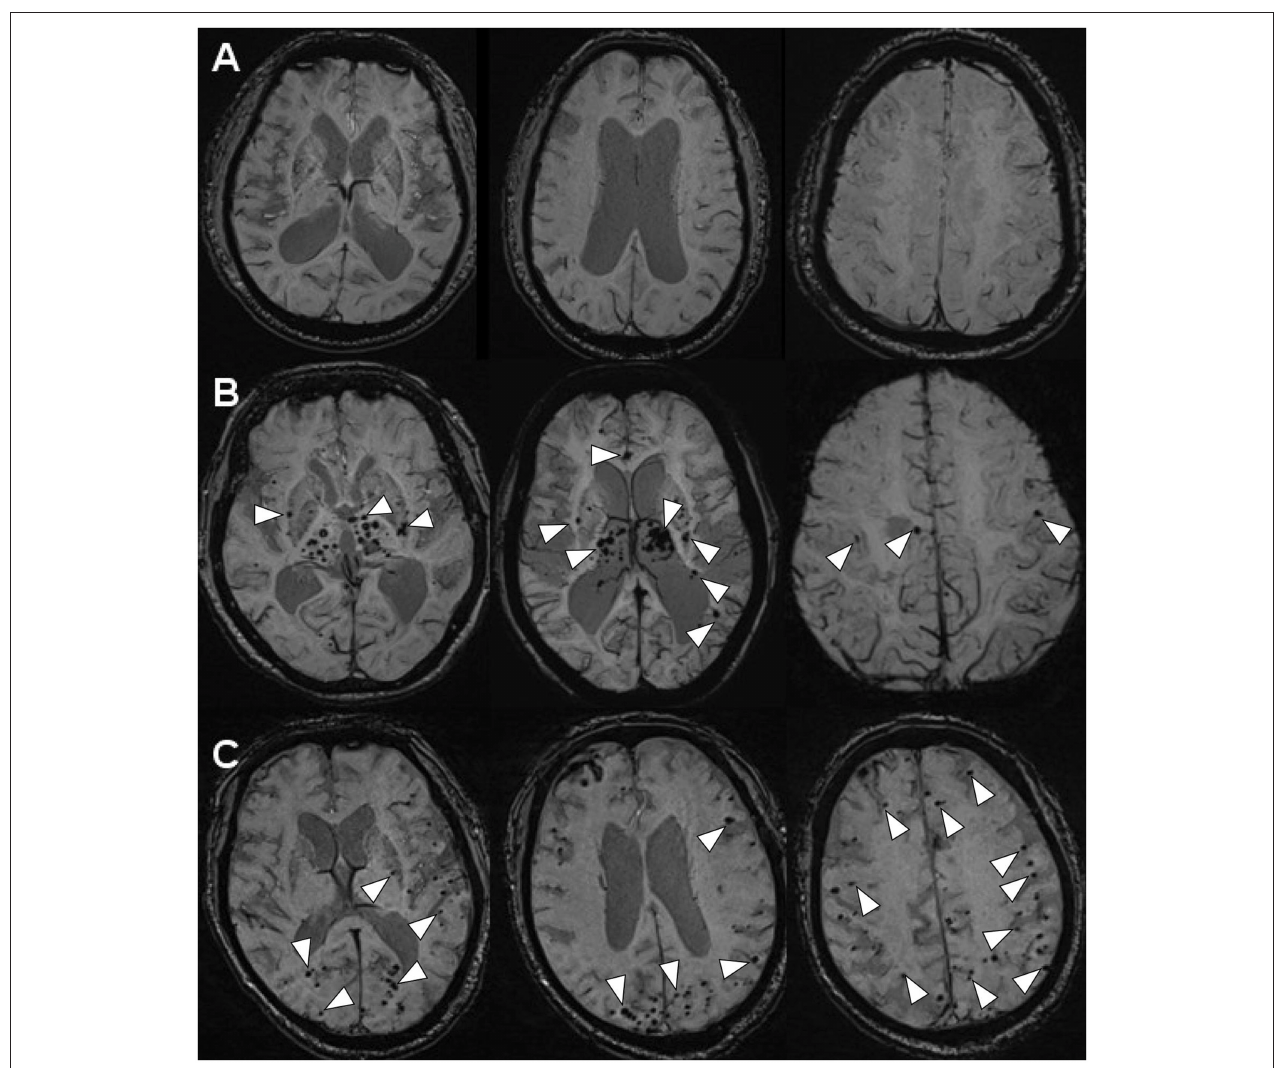
FIGURE 2 | The MR-SWI neuroimaging showed three different phenomena of CMBs in the brains. (A) INPH: no CMBs observed in the brain (case 1). (B) LA: multiple CMBs distributed in deep brain structures (the basal ganglia, the thalami, the corpus callosum, the internal capsule, external/extreme capsule) (case 2). (C) CAA: multiple CMBs distributed in the area of cerebral lobars (the cerebral cortices and the subcortical white matter) (case 3).